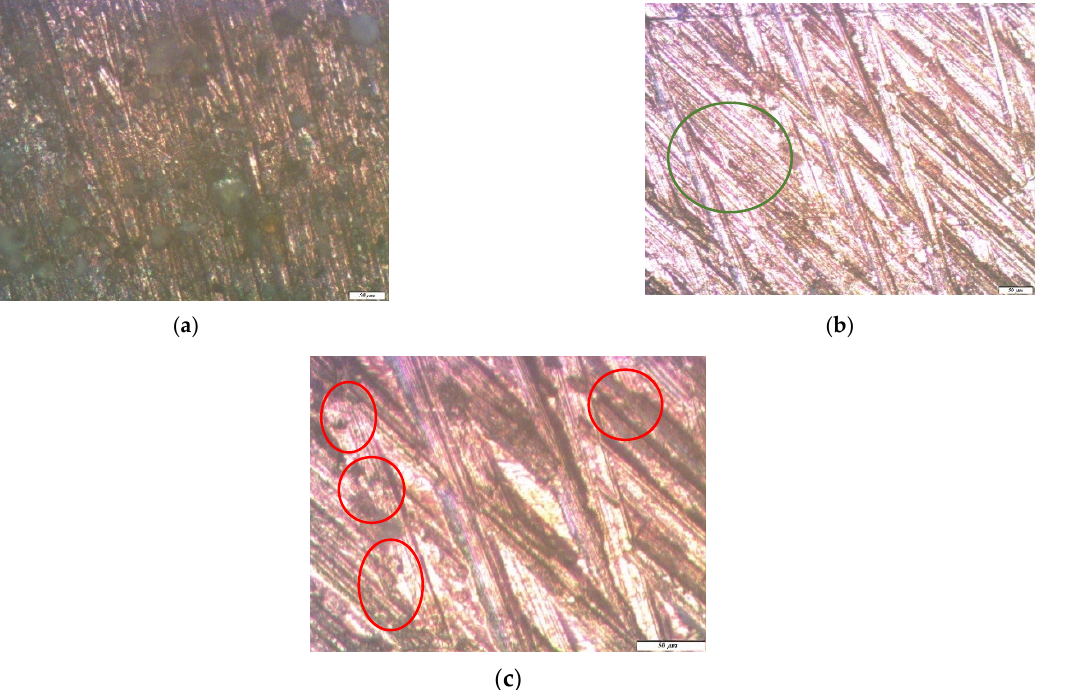
Figure 5. Micrographs of the surface area of an unmodified copper sample after conducting field tests in an urban atmosphere: ( a ) immediately after the tests but before the removal of the corrosion products; ( b ) after the removal of the corrosion products, at magnification 10×, where the green circle marks the area with pitting for a more detailed consideration; and ( c ) after enlarging the surface area (highlighted in ( b )), at magnification 20×, where the red circles or ovals highlight the corrosion defects (pittings).